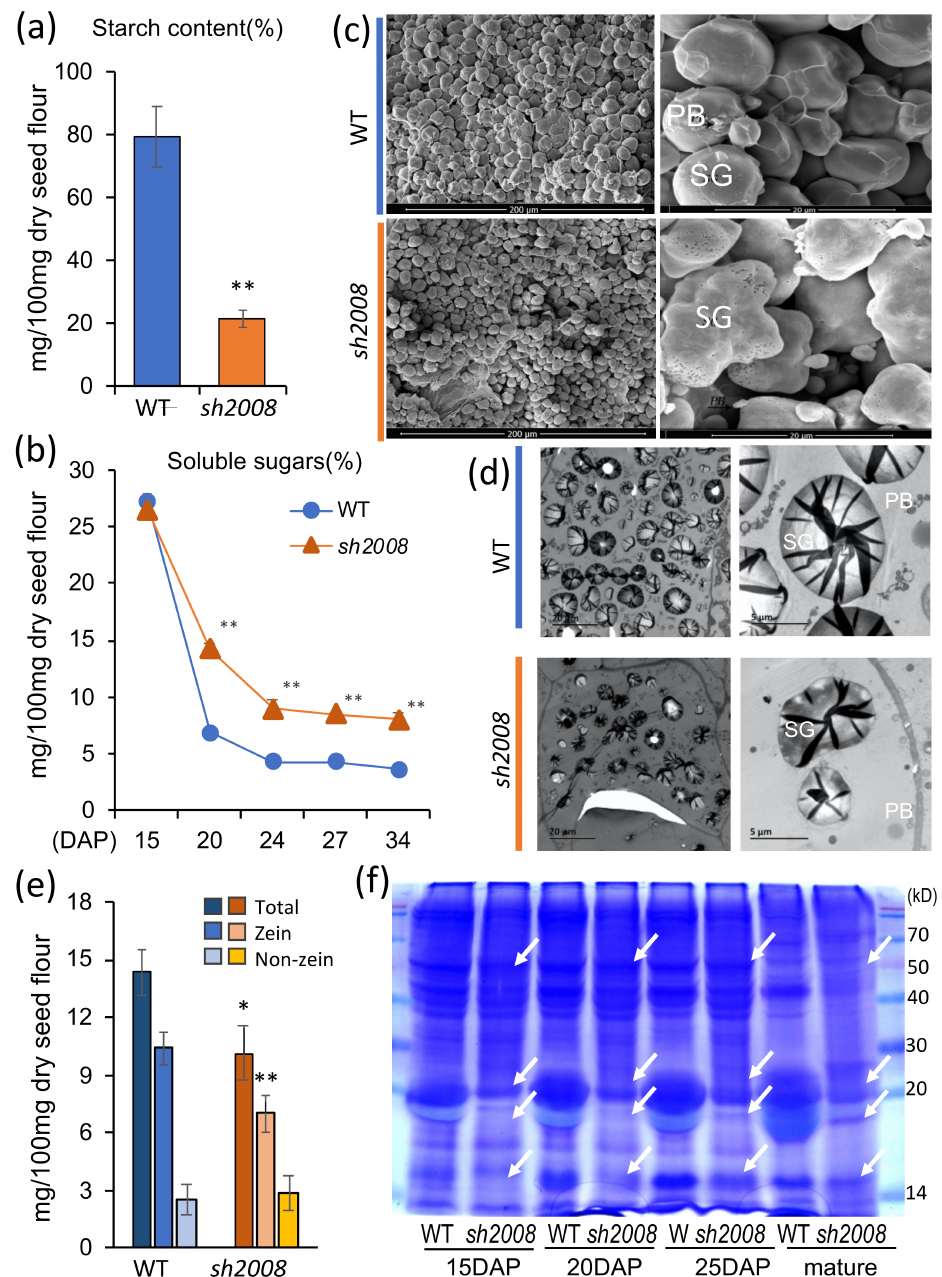
Figure 3. Storage carbohydrates and proteins in the WT and sh2008 . ( a ) The starch content of the kernels from the WT and sh2008 . The mature kernels were used for starch content measurements. Values are the means of the three replicates ± SD. ** denotes statistical significance with p < 0.01 by using a t -test. ( b ) The soluble sugars change in the WT and sh2008 after pollination. Kernels at 15, 20, 24, 27, and 34 DAP were used for soluble sugar content measurements. Values are the means of the three replicates ± SD. ** denotes statistical significance with p < 0.01 by using a t -test when compared with the value in the WT. ( c ) Scanning electron microscopy (SEM) analysis of the peripheral regions of the mature WT and sh2008 endosperm. SG, starch granule; PB, protein body. ( d ) Transmission electron microscopy (TEM) of the 20 DAP endosperm of the WT and sh2008 . SG, starch granule; PB, protein body. ( e ) The content of total protein, zein protein, non-zein protein in the WT and sh2008 . Values are the means of the three replicates ± SD. ** denotes statistical significance with p < 0.01 and * denotes statistical significance with p < 0.05 by using a t -test when compared with the value in the WT. ( f ) SDS-PAGE analysis of total protein, zein protein, and non-zein protein in the developing endosperms of the WT and sh2008 . The protein mark size of each band is indicated by number. kD, kDa; DAP, days after pollination. White arrows indicate the difference between sh2008 and